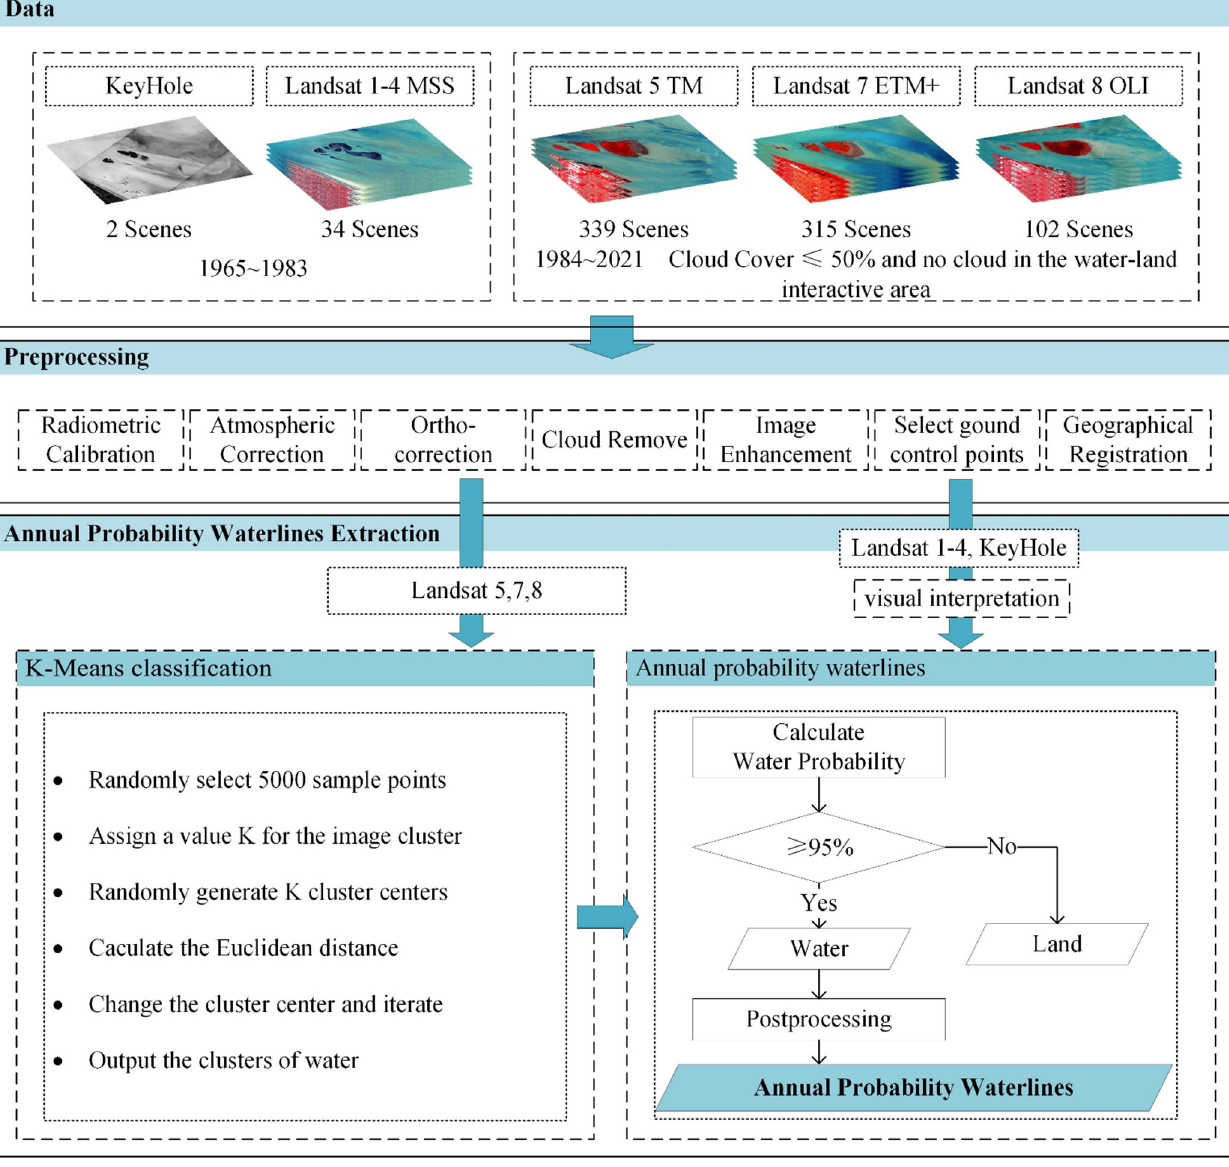
Figure 3. Framework of the annual probability waterlines extraction.